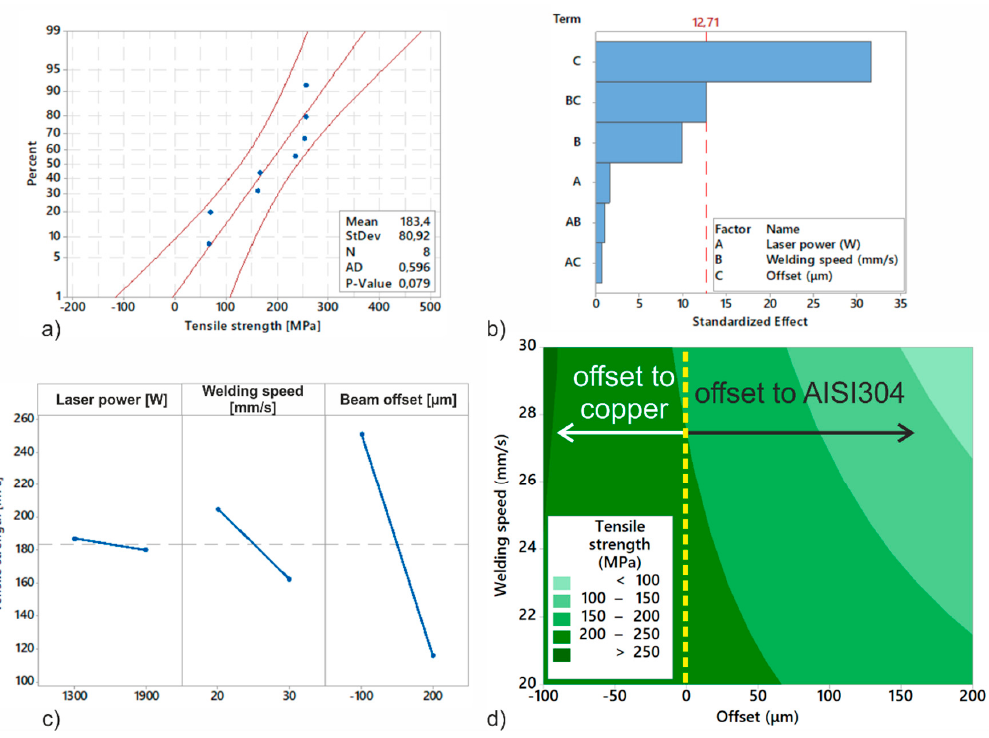
Figure 15. ( a ) Probability plot for tensile strength; ( b ) Pareto chart of the standardized effects; ( c ) main effects plot for tensile strength; ( d ) contour plot of tensile strength vs. welding speed and beam offset. Table 9. Results of analysis of variance for tensile strength of welded